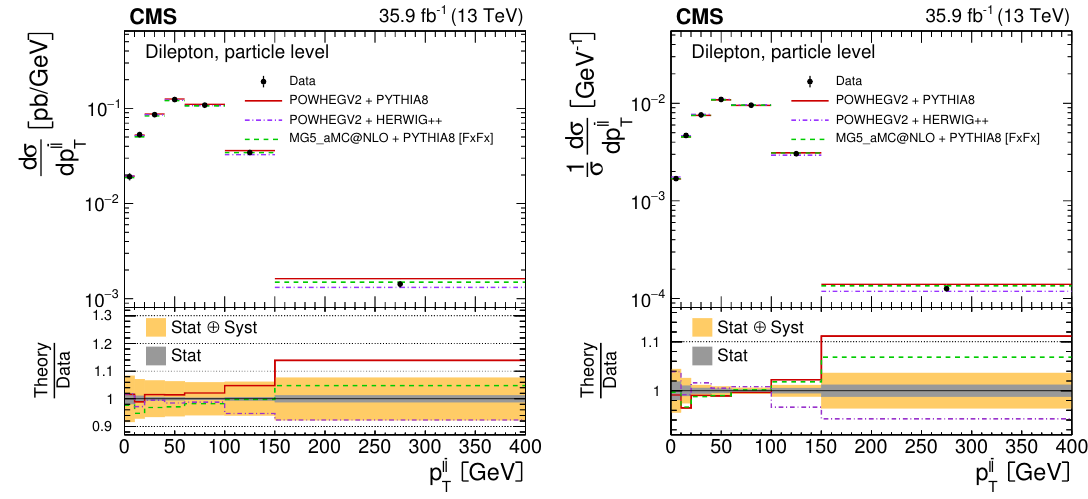
Figure 41 . The di(cid:11)erential tt production cross sections as a function of p ‘ (cid:22) ‘ at the particle level are shown for the data (points) and the MC predictions (lines). The vertical lines on the points indicate the total uncertainty in the data. The left and right plots correspond to absolute and normalised measurements, respectively. The lower panel in each plot shows the ratios of the theoretical predictions to the data. The dark and light bands show the relative statistical and total uncertainties in the data, respectively.